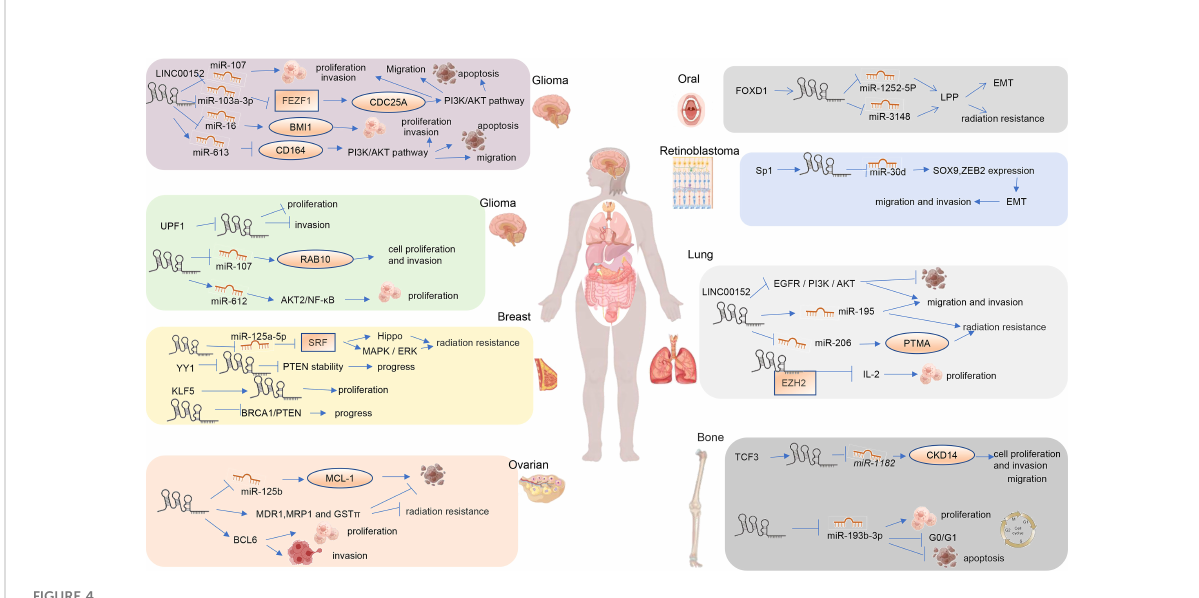
FIGURE 4 Mechanism of LINC00152 in regulating other human